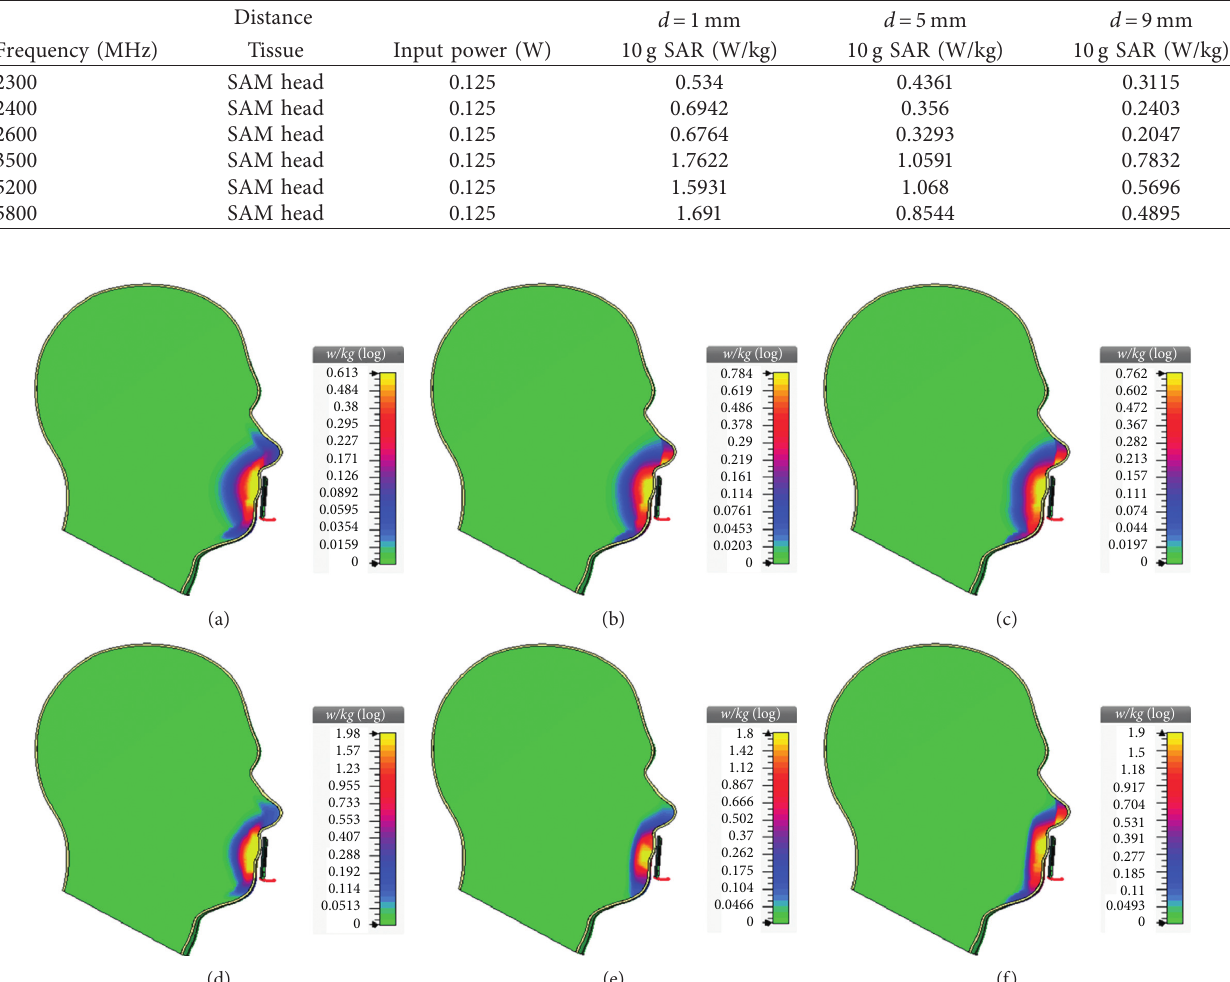
Table 6: Maximum SAR results at each frequency for each distance of antenna next to mouth.